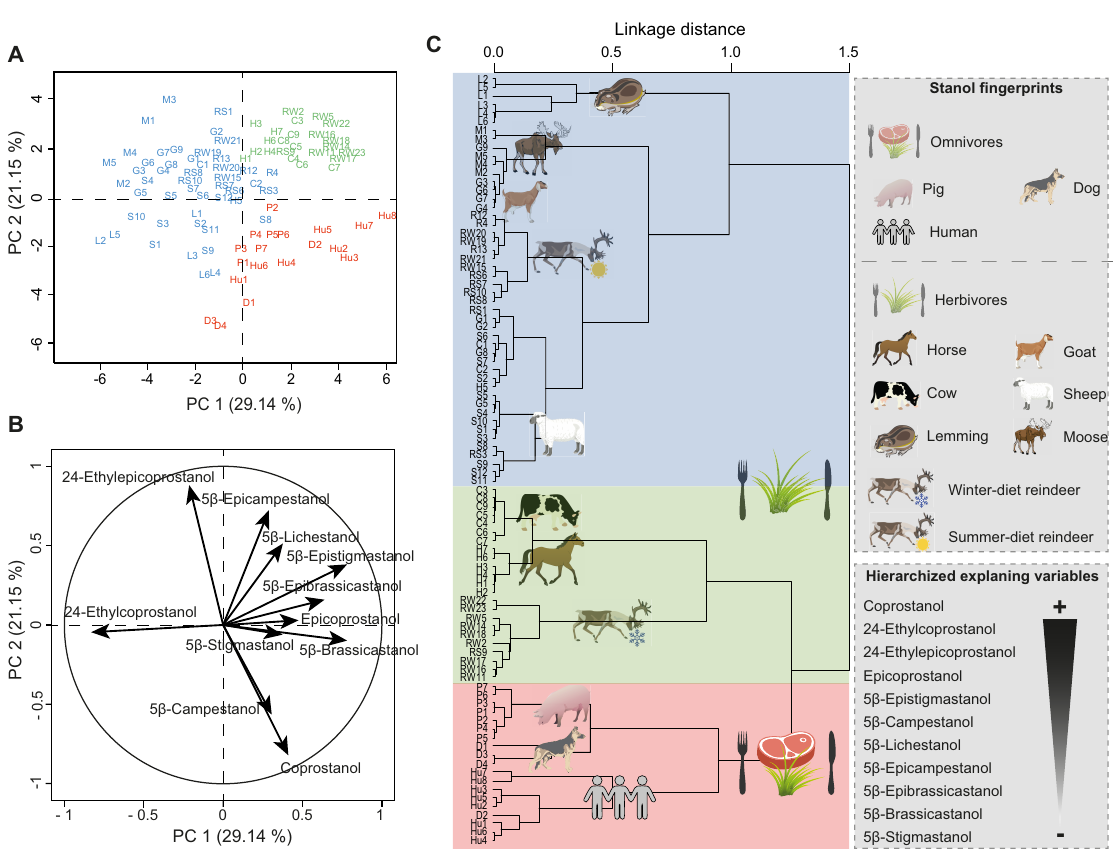
Fig 2. Mammal fingerprints. ( A ) PCA score plot of 5 β -stanol distributions in reindeer (R), lemming (L), goat (G), sheep (S), horse (H), moose (M), cattle (C), pig (P), dog (D) and human (Hu) faecal samples. Colours represent the main clusters obtained by HCPC ( C ). PC 1 and PC 2 represent respectively principal components 1 and 2; numbers in brackets show the variance explained by each PC. ( B ) PCA correlation circle. ( C) HCPC dendrogram of all species fingerprints built on PCs from the PCA. The main variables/compounds responsible for the distinction between the main clusters are hierarchized (from the more important + to the less import -) according to S4 Table. More details of the PCA/HCPC models can be found in S4 Table and sample information is in S2 Table.